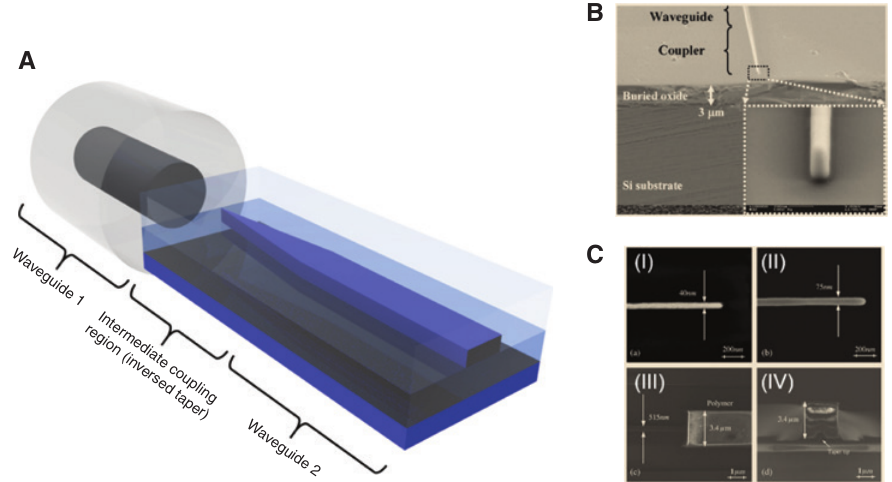
Figure 4: (A) Schematic diagram of an inversely tapered intermediate waveguide coupler with a low-index cladding. The integrated waveguide core region is represented with blue colors. (B) A typical inversely tapered waveguide coupler with SiO Reprinted from Ref. [55]. Copyright 2003 The Optical Society. (C) A coupler with a very narrow tip fabricated by silicon oxidation process and its SEM image. Silicon nano-taper tip end (I) before and (II) after oxidation process. (III) Top view of the junction point of a polymer core and a silicon waveguide. (IV) Cross-section view of the nano-taper coupler. Adapted from Ref. [39]. Copyright 2010